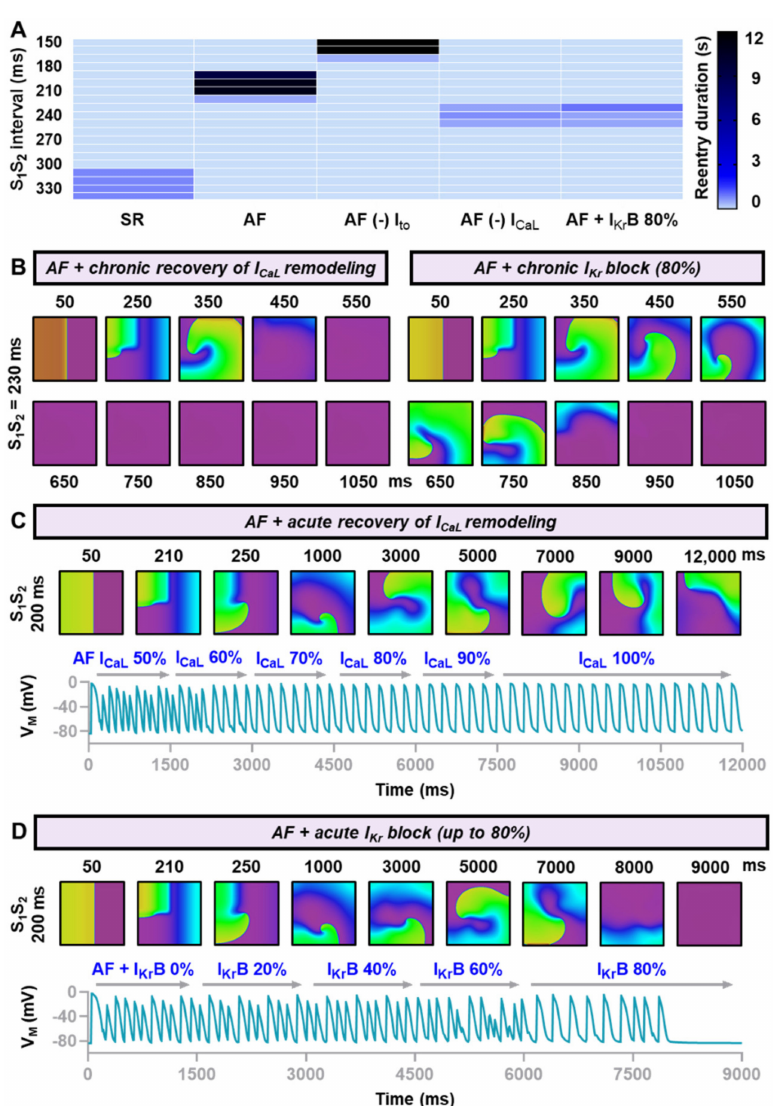
Figure 5. Chronic and acute effects of hypothetical treatment to restore the function of altered ion channels. ( A ) Vulnerable windows of the Courtemanche model comparing reentrant waves behavior under sinus rhythm (SR), atrial fibrillation (AF), AF without I to remodeling, AF without I CaL remodeling and AF with 80% I Kr block, mimicking the effect of class III antiarrhythmic drugs. ( B ) Chronic restoration of I CaL and chronic block of I Kr altered the stability of reentry, resulted in the abbreviation of reentry duration. ( C , D ) The acute effects of I CaL restoration and I Kr block on cardiac